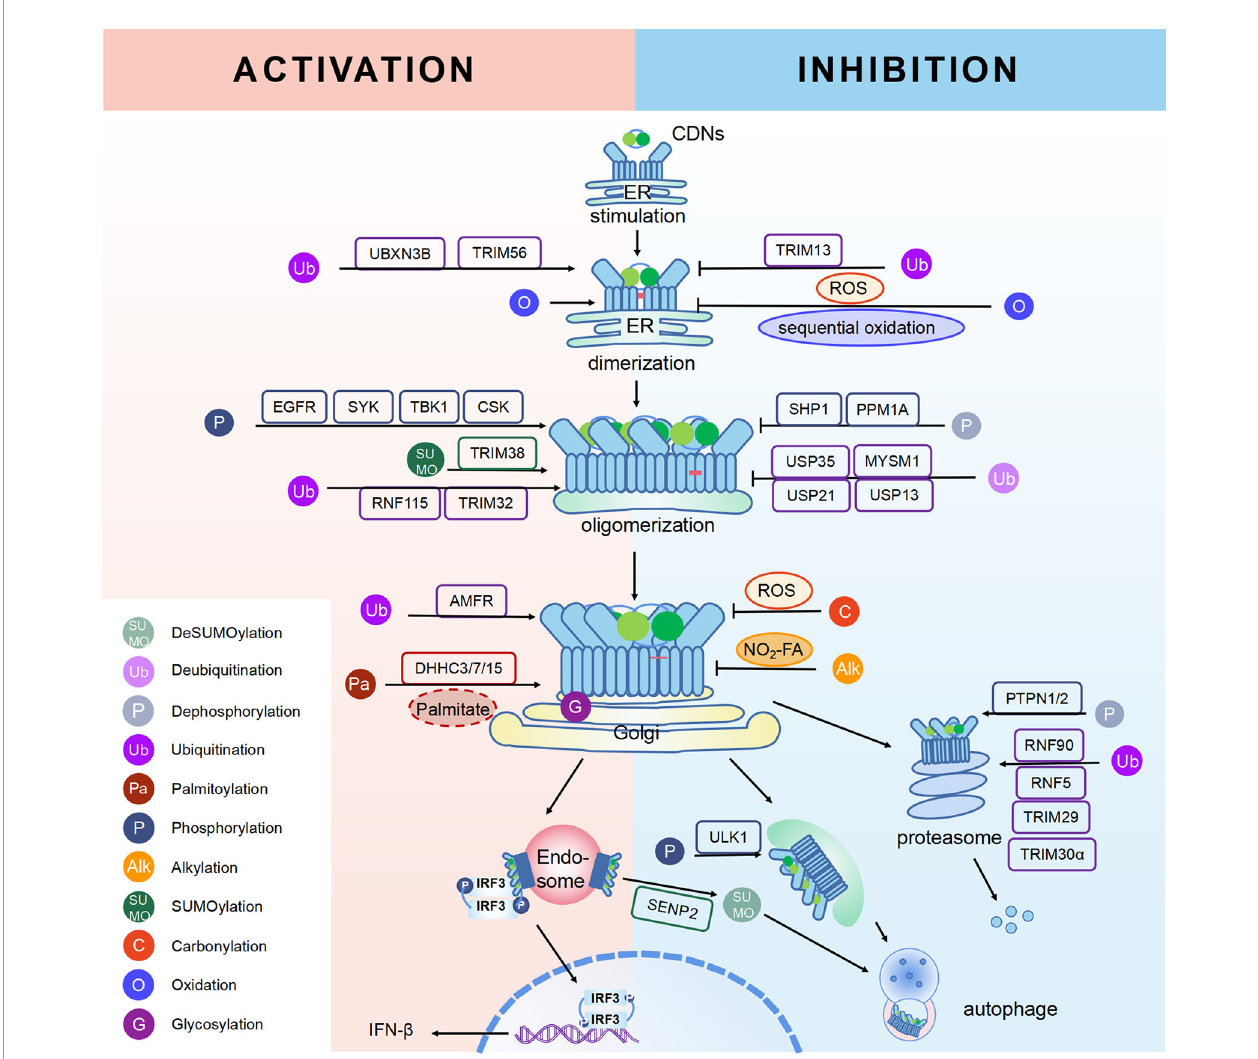
FIGURE 2 | PTMs in STING pathway. PTMs are going along with the life of STING, from activation to degradation. When CDNs bind to STING, STING is recruited and dimerized with the help of reversible oxidation and disul fi de bond. SUMOylation and ubiquitination can help STING with oligomerization, while phosphorylation is related to the activation of STING. Then STING transports from ER to Golgi. Palmitoylation and sGAGs could help STING reside on Golgi, thus continuous activation of STING leads to increasing pro-in fl ammatory cytokines. On the other hand, inhibition of STING happens along with activation to achieve cellular homeostasis. Sequential oxidation inhibits STING dimerization. Dephosphorylation and deubiquitination of STING decrease the oligomerization of STING. Also, carbonylation caused by ROS and alkylation caused by NO 2 -FAs can competitively inhibit palmitoylation and block sequential residence of STING on Golgi, thus immune responses are inhibited. In addition, dephosphorylation, ubiquitination and deSUMOylation could facilitate protein degradation to maintain